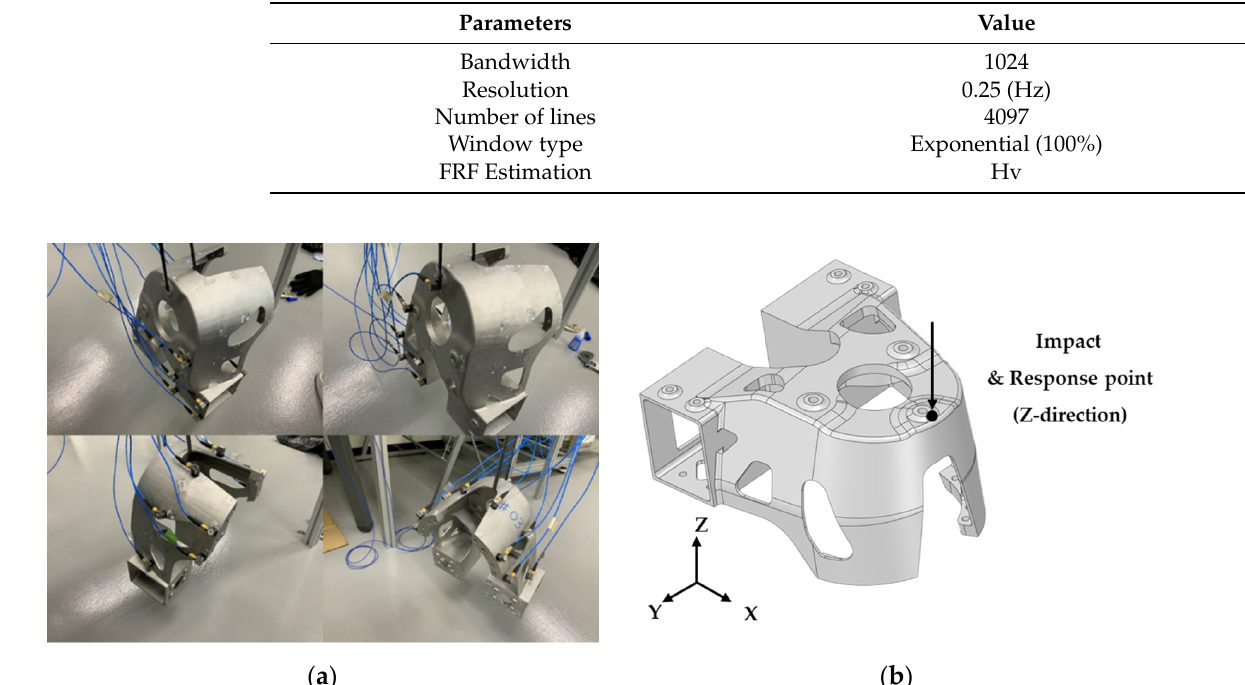
Figure 15. Impact testing process for additive-manufactured product. ( a ) aetting of free-free condition in impact experiment and roving of accelerometer; ( b ) the excitation position of the impact hammer and the position of the acceleration response (z-direction).